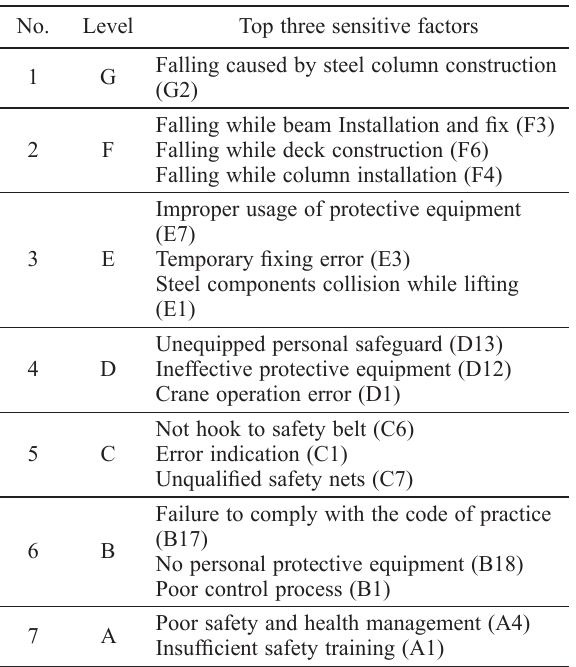
Table 2. Top sensitivity factors of fall risk at SC projects no.